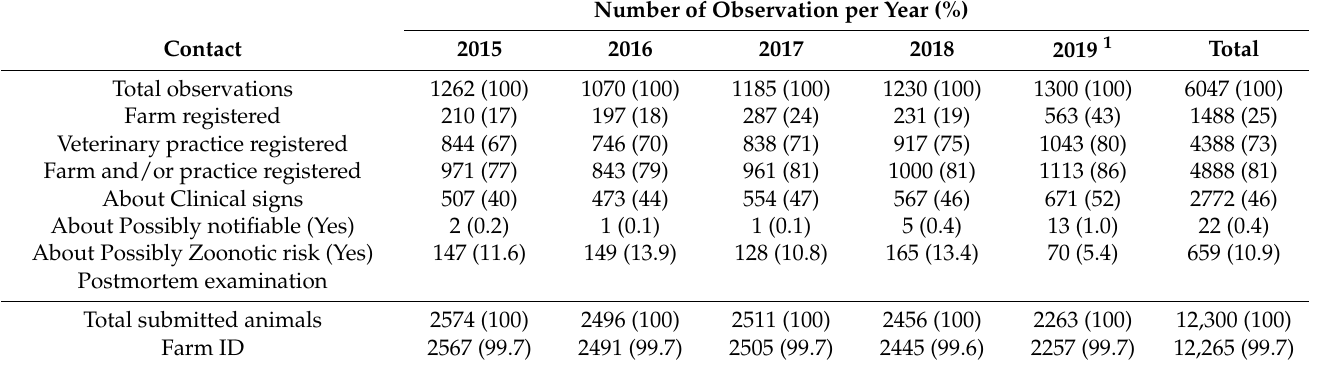
Table 5. Descriptive statistics of veterinary helpdesk contact and postmortem examinations for pigs in the Netherlands from 2015 to 2019.